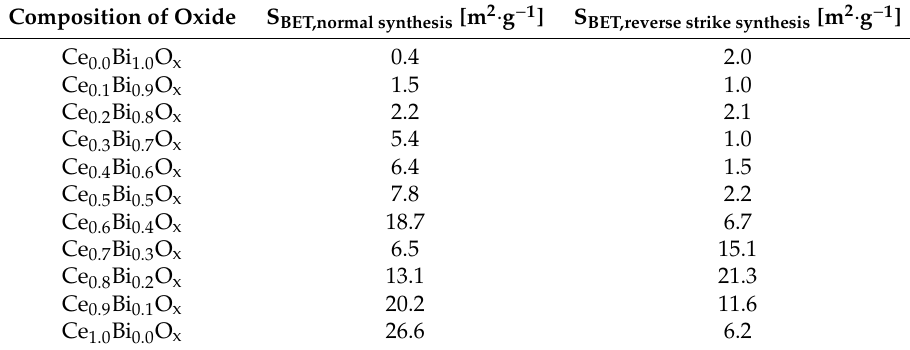
Table 3. Calculated specific surface areas according to Brunauer, Emmett, and Teller ( S BET ) of the synthesized mixed Bi-Ce oxides determined by nitrogen adsorption measurements. Oxides are calcined at T = 800 ◦